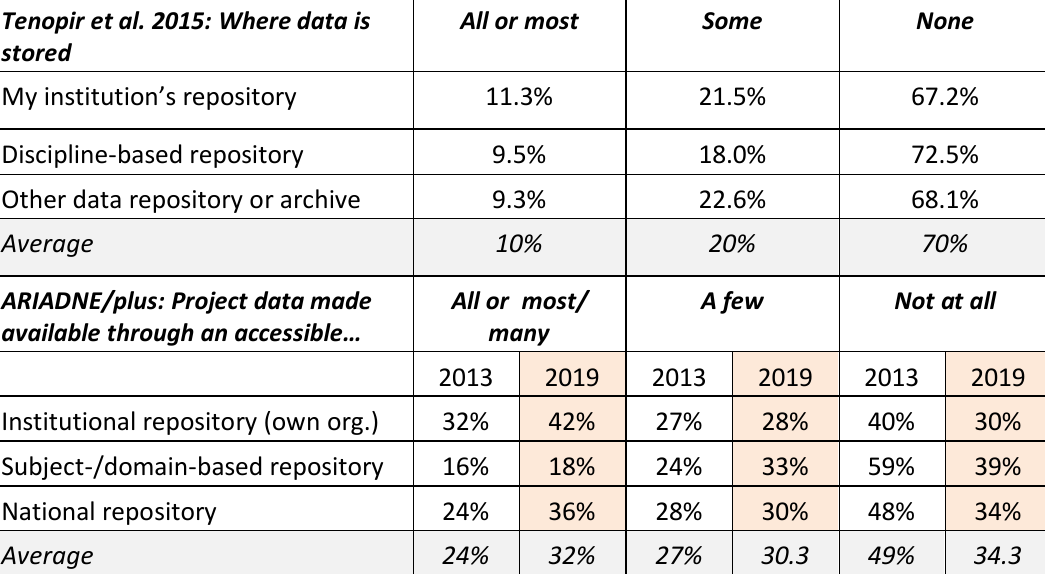
Tenopir et al. 2011 versus